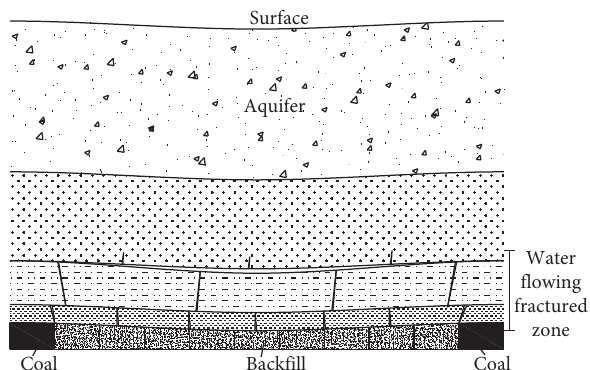
Coal Figure 5: Schematic diagram of water flowing fractured zone in backfill